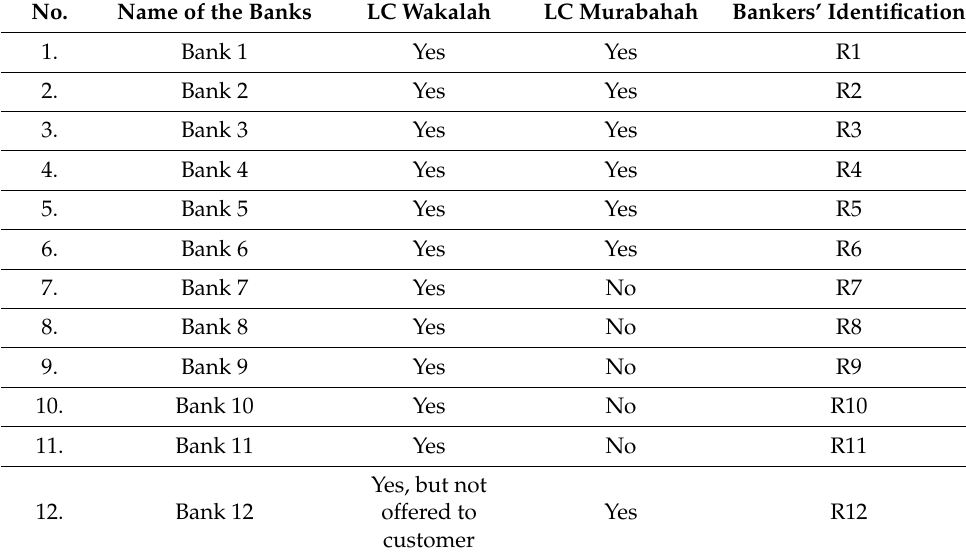
Table 1. Islamic Banks in Malaysia and the Types of Letter of Credit Offered. No. Name of the